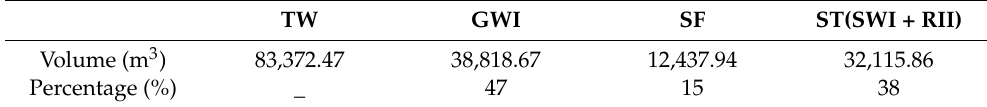
Table 5. Division of wastewater effluent to the wastewater treatment (TW) plant in the components groundwater infiltration (GWI), domestic wastewater (SF) and rainwater (ST). TW